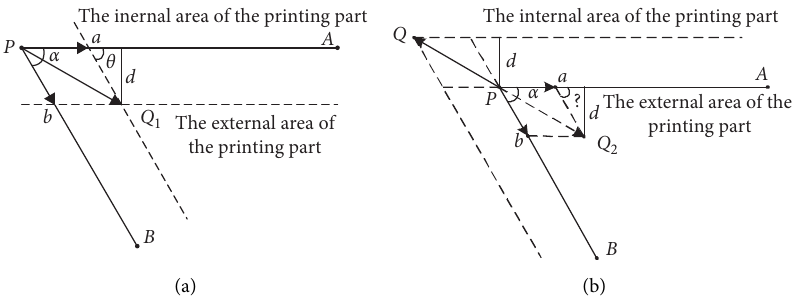
Q 1 The external area of